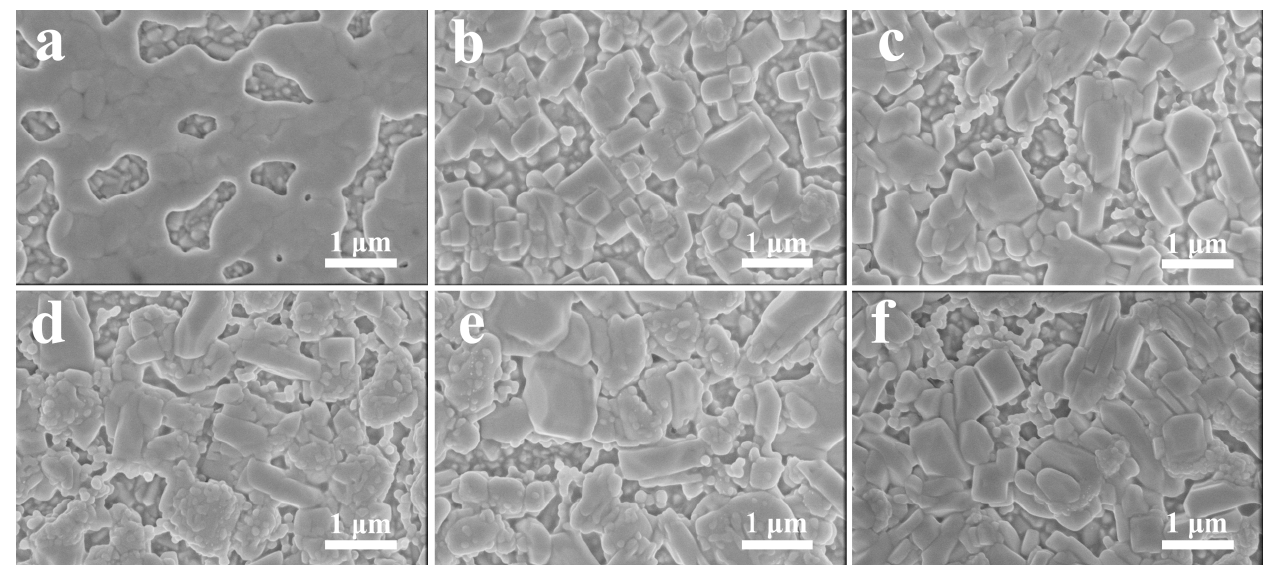
Figure 1. Top-view SEM images of PbBr 2 films synthesized with different PbBr 2 concentration: ( a ) 1.0 M w/o InBr 3 ; ( b ) 1.0 M w/ InBr 3 ; ( c ) 1.1 M w/ InBr 3 ; ( d ) 1.2 M w/ InBr 3 ; ( e ) 1.3 M w/ InBr 3 ; ( f ) 1.4 M w/ InBr 3 .